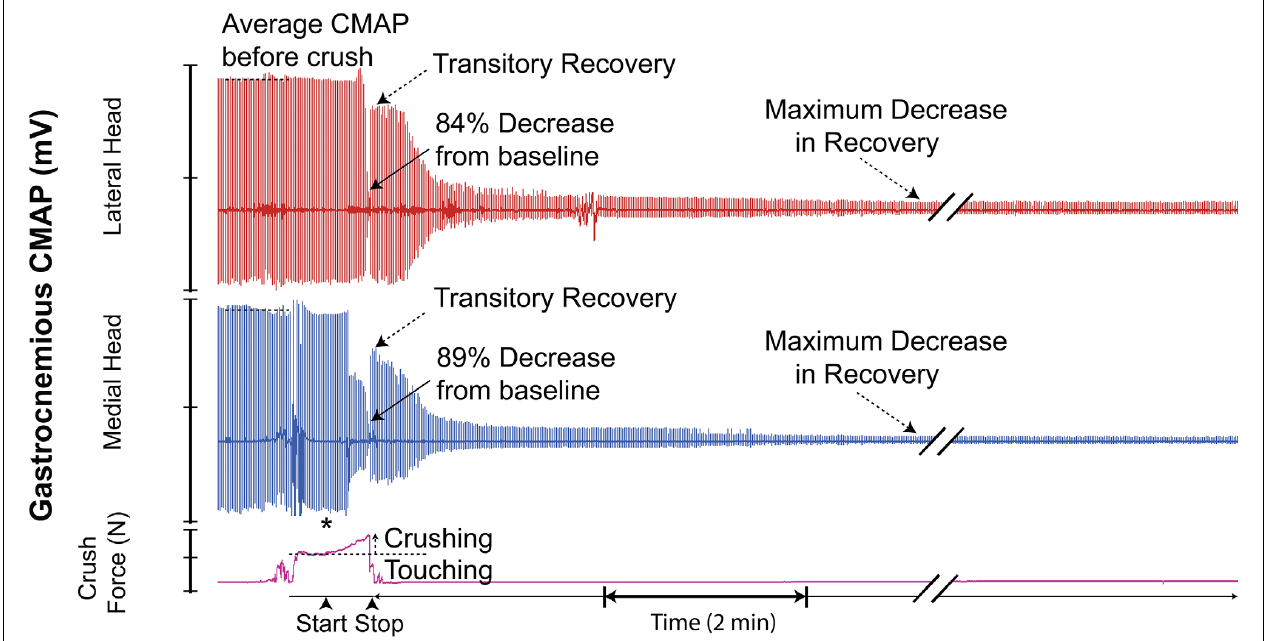
FIGURE 7 | Recording demonstrating the typical two-channel CMAP response observed before, during, and after inducing a controlled compressive lesion on the tibial nerve. The force involved in touching the nerve and the subsequent graded increase in applied pressure required to induce axonotmesis is shown. This recording demonstrates transient partial CMAP amplitude recovery after sustaining the injury. The recovery was followed by a further decline. * = beginning of force increase.